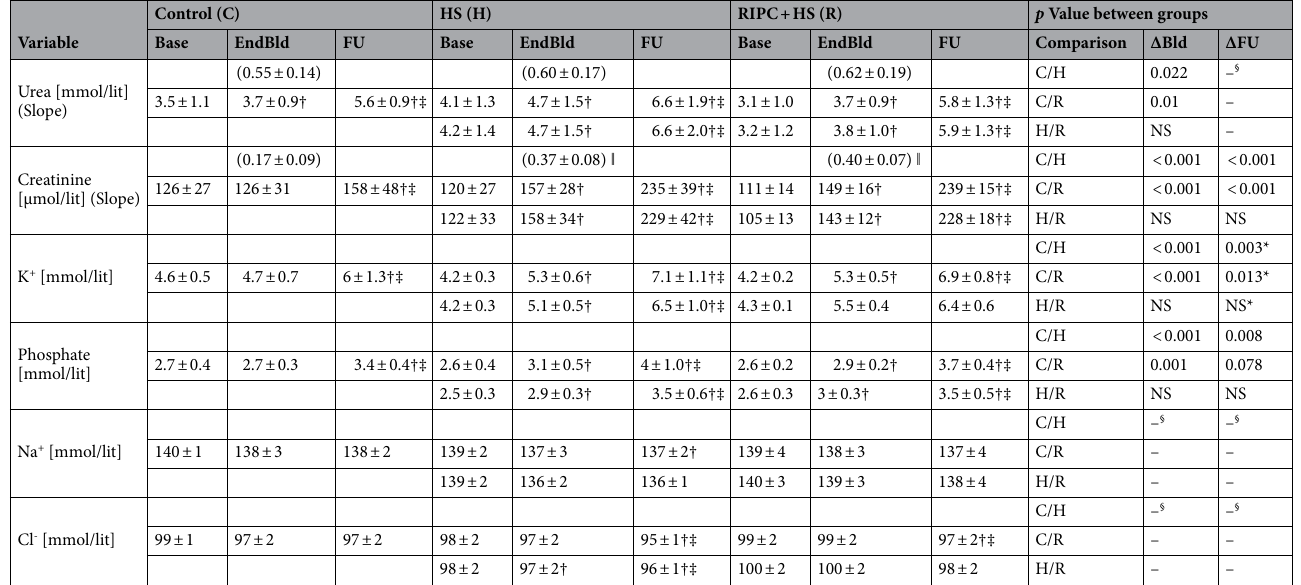
Table 3. Kidney Functions. Data presented as mean ± SD. Numbers in first row of each parameter are for all animals. Numbers in second row of each parameter are only those that survived (6 h of follow-up: Controls, n = 7 at all time-points; HS, n = 13 at 2H, n = 10 at 4H, n = 9 at 6H; RIPC + HS, n = 8 at 2H and 4H, n = 5 at 6H). Numbers in parentheses represent slope. Normality was determined by Shapiro–Wilk (SW) test ( p > 0.1). Comparisons between baseline, end of bleeding [EndBld], and follow-up [FU] (mean over 7-h follow-up) within groups were performed by paired t-test with Bonferroni’s correction for multiple comparisons or Friedman’s test with pairwise comparisons as post-hoc test as appropriate (according to SW). Comparisons between groups or slope (change over follow-up time calculated individually by linear regression) were conducted by analysis of variance (ANOVA) with Fisher’s least significance difference (FLSD) as post-hoc test or Kruskal–Wallis (KW) with Conover-Iman as post-hoc test. ΔBld = (EndBld-Baseline), ΔFU = (FU-EndBld), *ΔFU = (FU-Baseline). p < 0.05 considered significant and all tests 2-tailed. † p < 0.05 versus baseline; ‡ p < 0.05 versus EndBld; § not significant by ANOVA/KW; ‖ p < 0.05 versus Control by